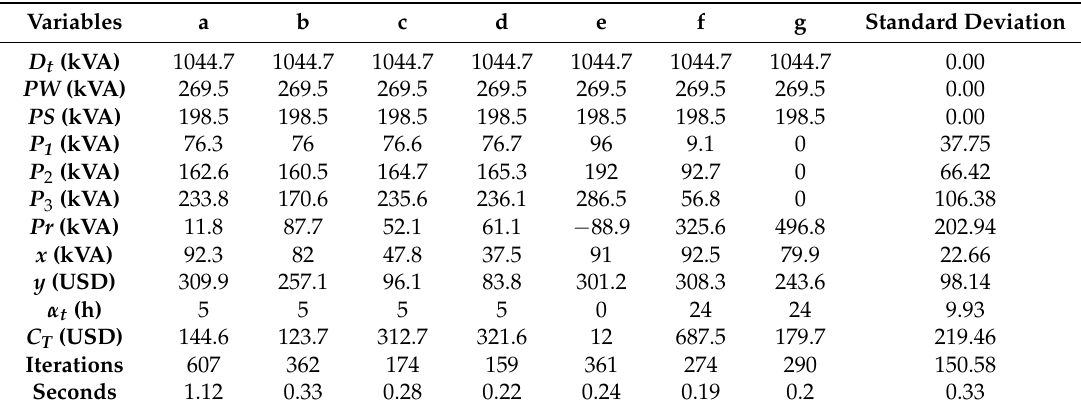
Table 7. Sensitivity